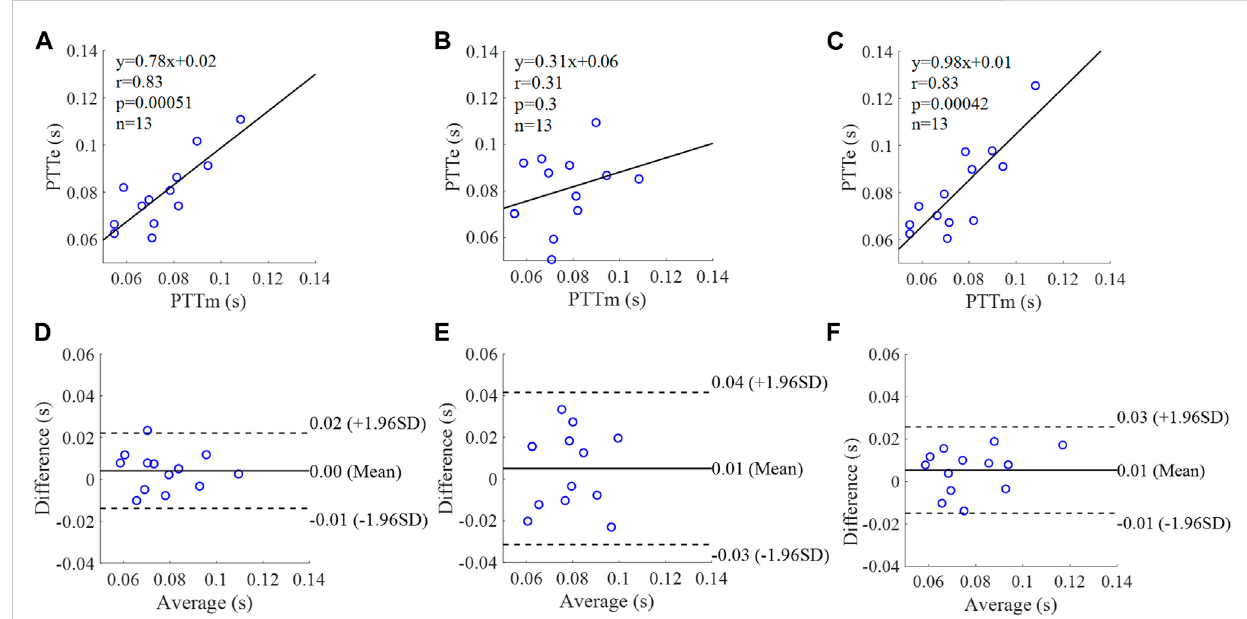
FIGURE 15 Correlation graphs and Bland-Altman plots of PTT calculated by three fl ow waveforms (A) and (D) Results of the personalized fl ow wave (Clinical data, 13 participants); (B) and (E) Results of the triangular fl ow wave (Clinical data, 13 participants); (C) and (F) Results of the lognormal fl ow wave (Clinical data, 13 participants). PTTm and PTTe are measured and estimated PTT, respectively. Difference: PTTe - PTTm; Average: (PTTe +